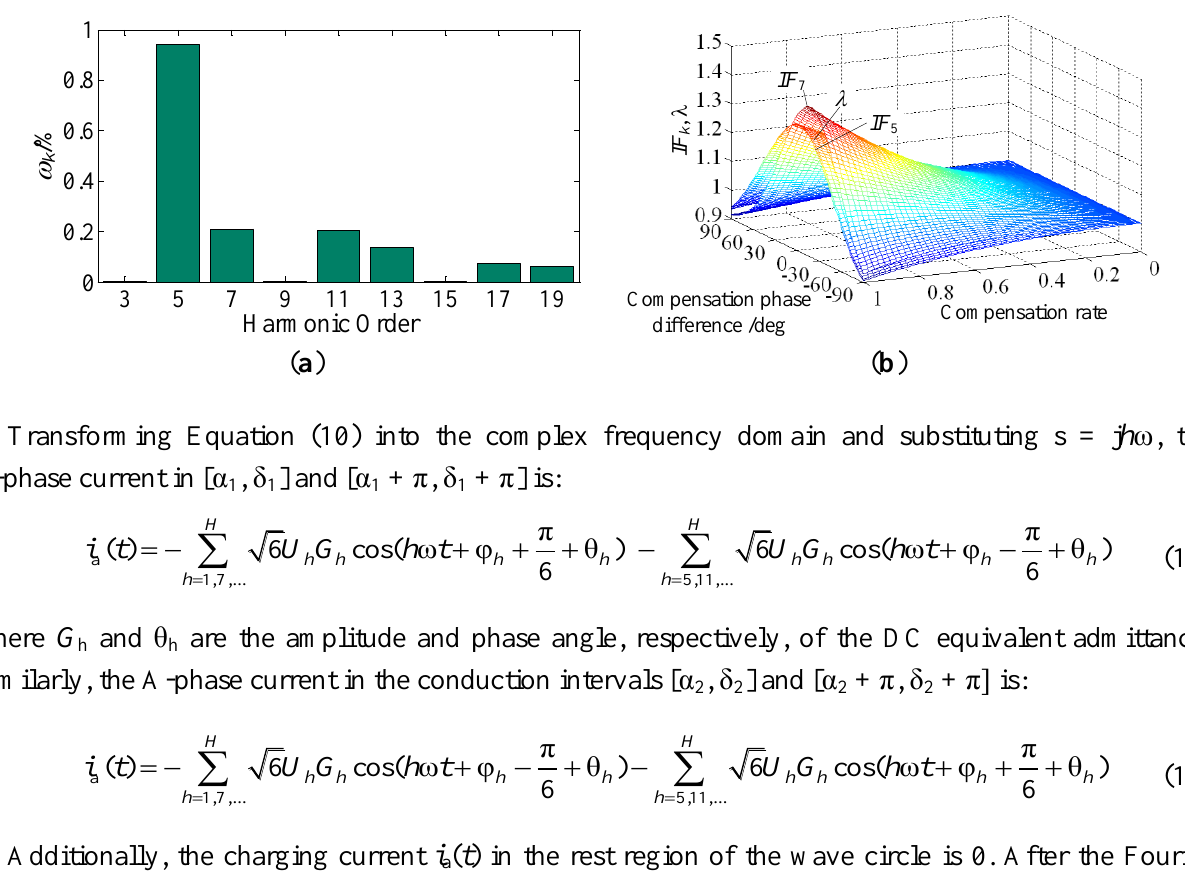
Figure 8. Relation between the overload coefficient and amplification coefficient of the harmonic current. ( a ) Weighting of each current harmonic; ( b ) Variation of IF the compensation rate and compensation phase